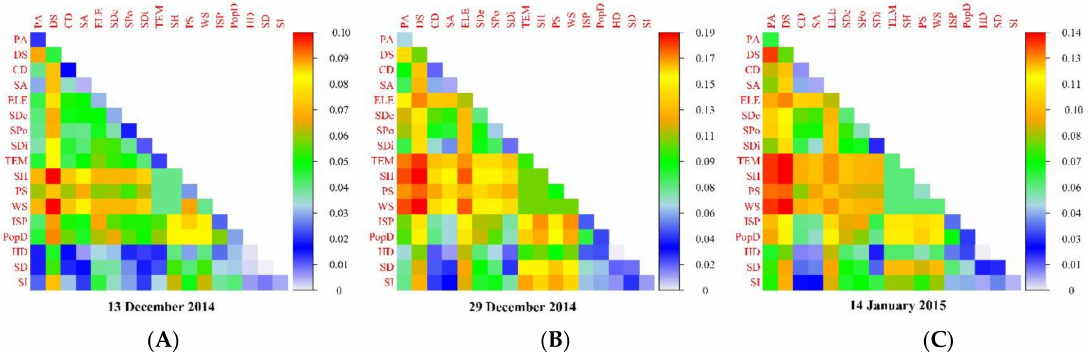
Figure 5. Scores for the interactive effects of impact factors sensitivity rankings at the three periods studied calculated based on simulations using multisource data (( A ) 13 December 2014; ( B ) 29 December 2014; ( C ) 14 January